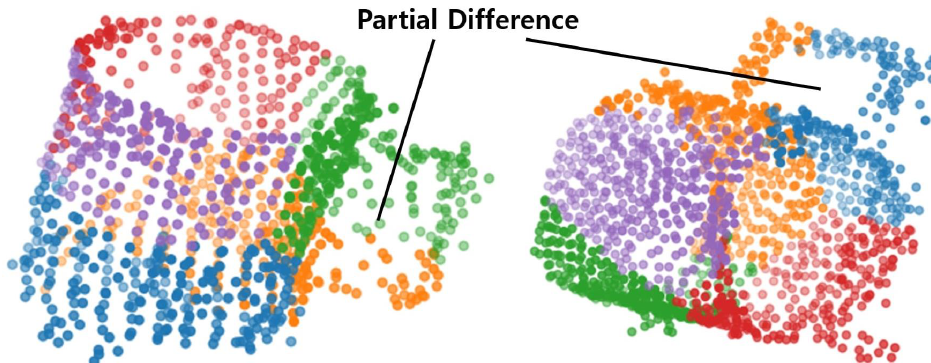
Figure 11. Partial